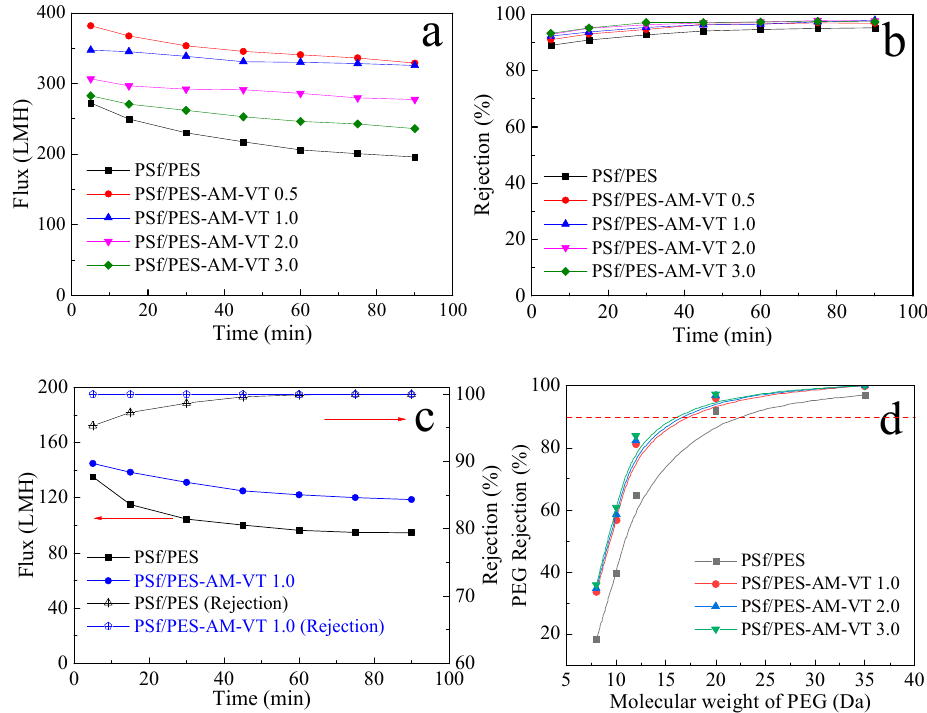
Figure 10. Time-dependent permeate fluxes ( a ) and rejection percentages ( b ) of various membranes during filtration of a 5 mg · L − 1 humic acid (HA) solution. ( c ) Time-dependent permeate fluxes ) of various membranes during filtration of a 200 mg · L − 1 bovine serum albumin (BSA) solution. ( d ) PEG rejection as a function of molecular weight cutoff (MWCO) for all the membranes.